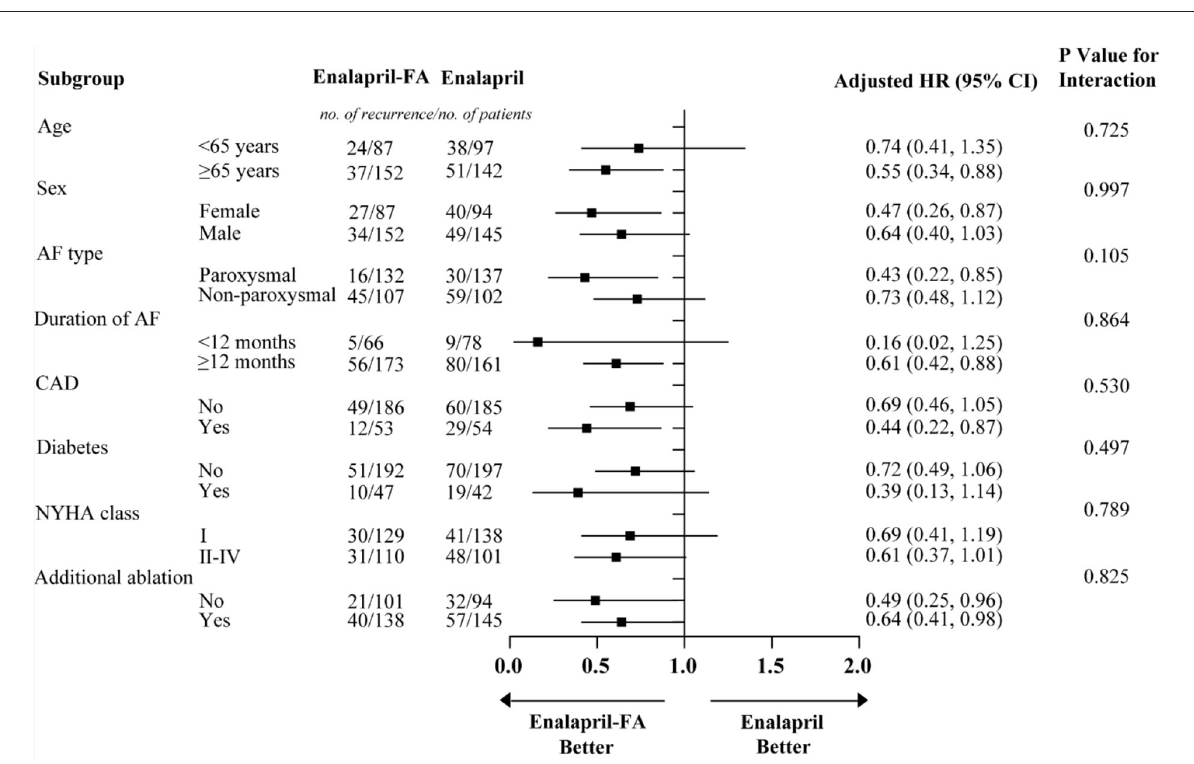
FIGURE4 Subgroup analysis for AF recurrence rates in patients with enalapril-FA and enalapril. Models were adjusted for BMI, smoking status, alcohol drinking status, SBP, DBP, eGFR, Scr, UA, BNP, HbA1c, TC, TG, HDL-c, LDL-c, LAD, LVEF, beta-blockers, CCB, statins, MRA, diuretics, digoxin, AADs and history of diseases (HF, hyperlipidaemia and renal insufficiency). FA, folic acid; AF, atrial fibrillation; BMI, body mass index; SBP, systolic blood pressure; DBP, diastolic blood pressure; eGFR, estimated glomerular filtration rate; Scr, serum creatinine; UA, uric acid; BNP, brain natriuretic peptide; TC, total cholesterol; TG, triglyceride; HDL-c, high-density lipoprotein cholesterol; LDL-c, low-density lipoprotein cholesterol; LAD, left atrial diameter; LVEF, left ventricular ejection fraction; CCB, calcium channel blocker; MRA, mineralcorticoid recept antagonist; AADs, antiarrhythmic drugs; HF, heart failure; HR, hazard ratio; CI: confidence